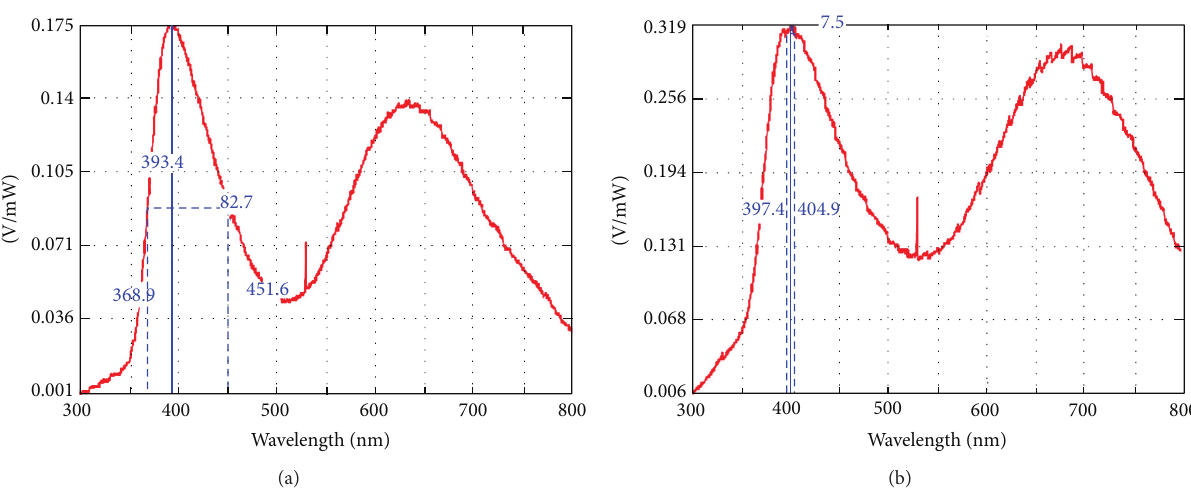
Figure 5: PL spectrum of GaN:Mn nanowires (a) PL data of GaN nanowires and (b) PL data of GaN:Mn